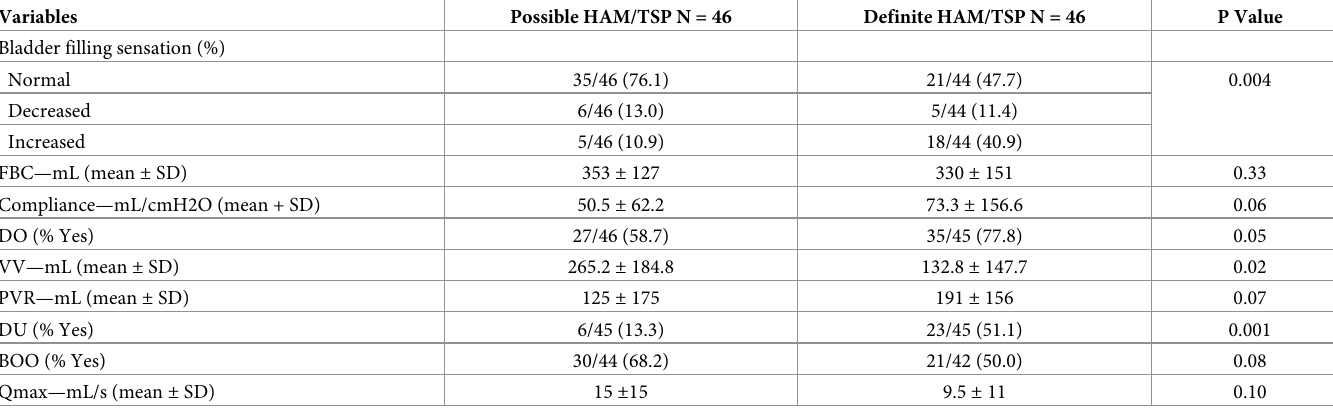
Table 2. Baseline Urodynamic Findings in a cohort of 92 HTLV-1-Infected Patients; Evaluation of Urinary Manifestations in Patients with Possible and Definite HTLV-1 Associated Myelopathy.